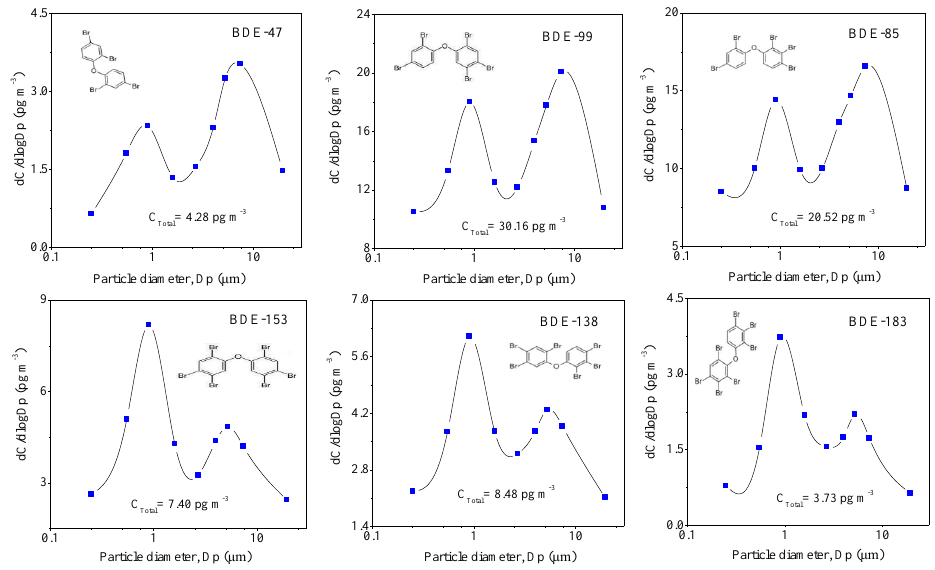
Figure 3. Mean normalized size distribution of particle-associated PBDEs for all samples. d C is the concentration on each filter, C is the sum concentration on all filters and dlog D p is the logarithmic size interval for each impactor stage in particle diameter ( D p ).